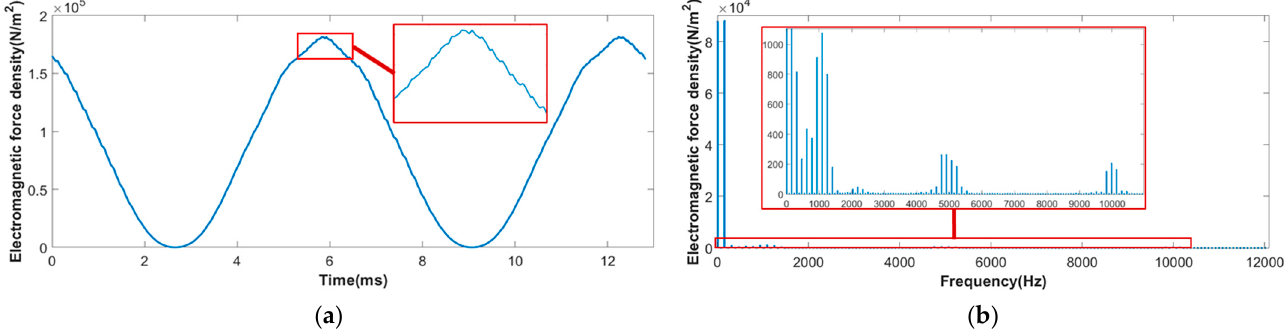
Figure 6. Electromagnetic force density under frequency converter drive: ( a ) electromagnetic force density waveform and ( b ) spectrum diagram of electromagnetic force density.